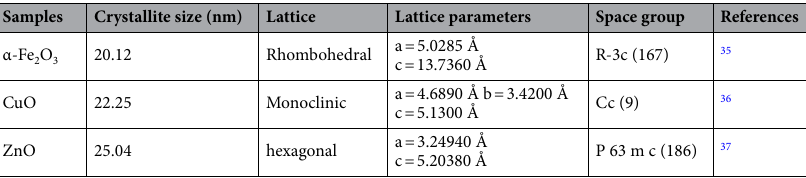
Table 1. Crystallite size of α-Fe 2 O 3 , CuO and ZnO NPs obtained by different pH values.